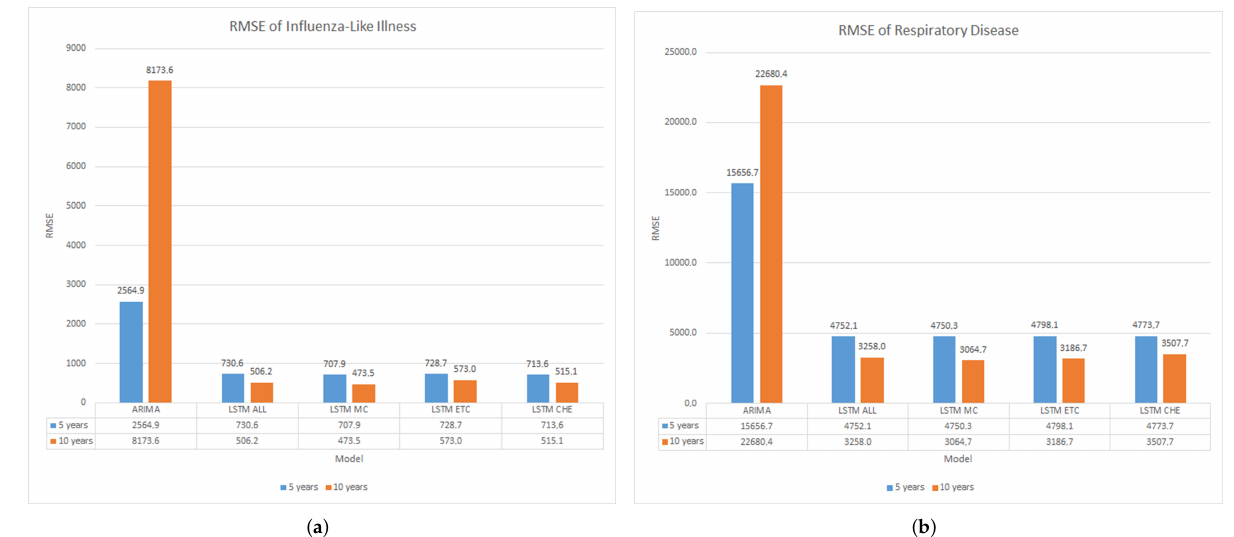
Figure 7. The model comparison results in graphs. ( a ) The RMSE of Influenza-like Illness; ( b ) The RMSE of Respiratory Disease.